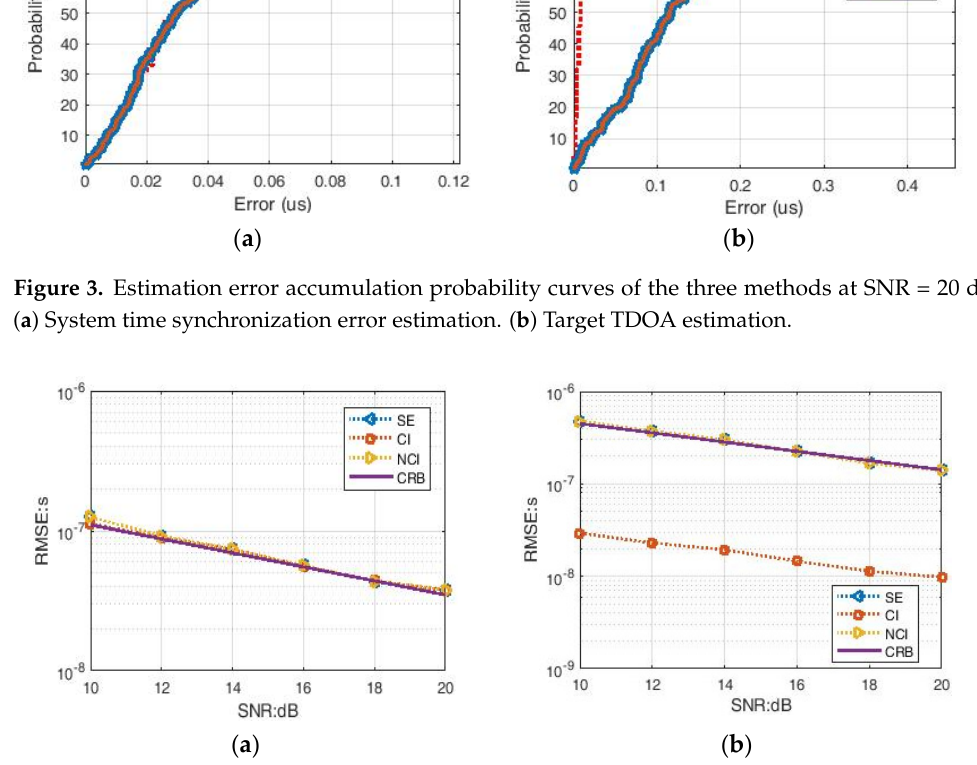
Figure 4. Estimation performance comparison of the three methods and CRB. ( a ) System time synchronization error estimation. ( b ) Target TDOA estimation.